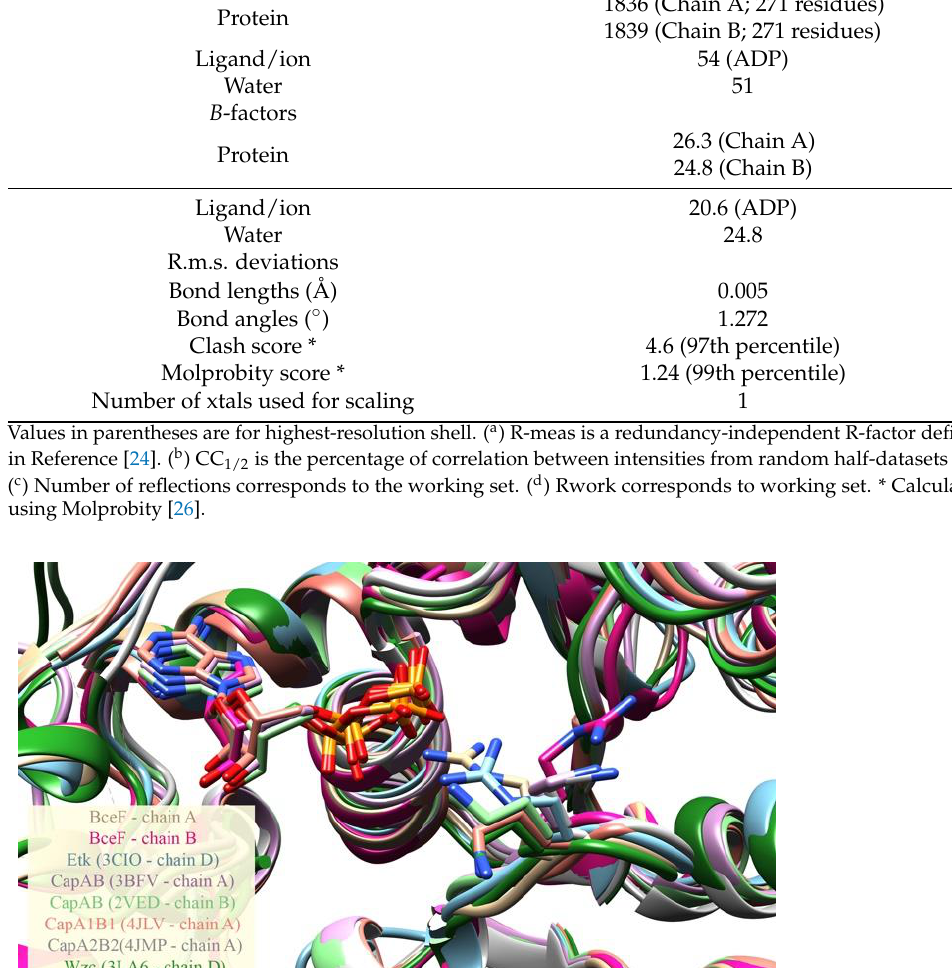
Figure 2. Conformational variability of the ADP-proximal residue Arg590 in BceF and its equivalent positions in other BY-kinases. ADP is present in both BceF chains, and CapAB (PDB Ids 3BFV, 2VED and 4JLV). ADP carbons are colored the same as the backbone of the protein from the same determined structure. The figure depicts a structural superimposition of the kinase domain of several BY-kinases, and of the two chains in the asymmetric unit in the crystal structure of BceF, with zoom-in into the ADP ligand and into the Arg590 residue in BceF and the equivalent positions in the other BY-kinases, shown as sticks. Side-chain atoms are colored by atom types (nitrogen in blue, oxygen in red and sulfur in yellow). The backbone and carbon atoms in each BY-kinase and BceF chain are colored differently: BceF chain A in beige, BceF chain B in magenta, Etk (PDB code 3CIO) in cyan (featuring the equivalent Arg572), CapAB (PDB code 3BFV in purple, PDB code 2VED in light green, PDB code 4JLV in orange, PDB code 4JMP in grey), featuring the equivalent Lys1082, and Wzc (PDB code 3LA6 in dark green), featuring the equivalent